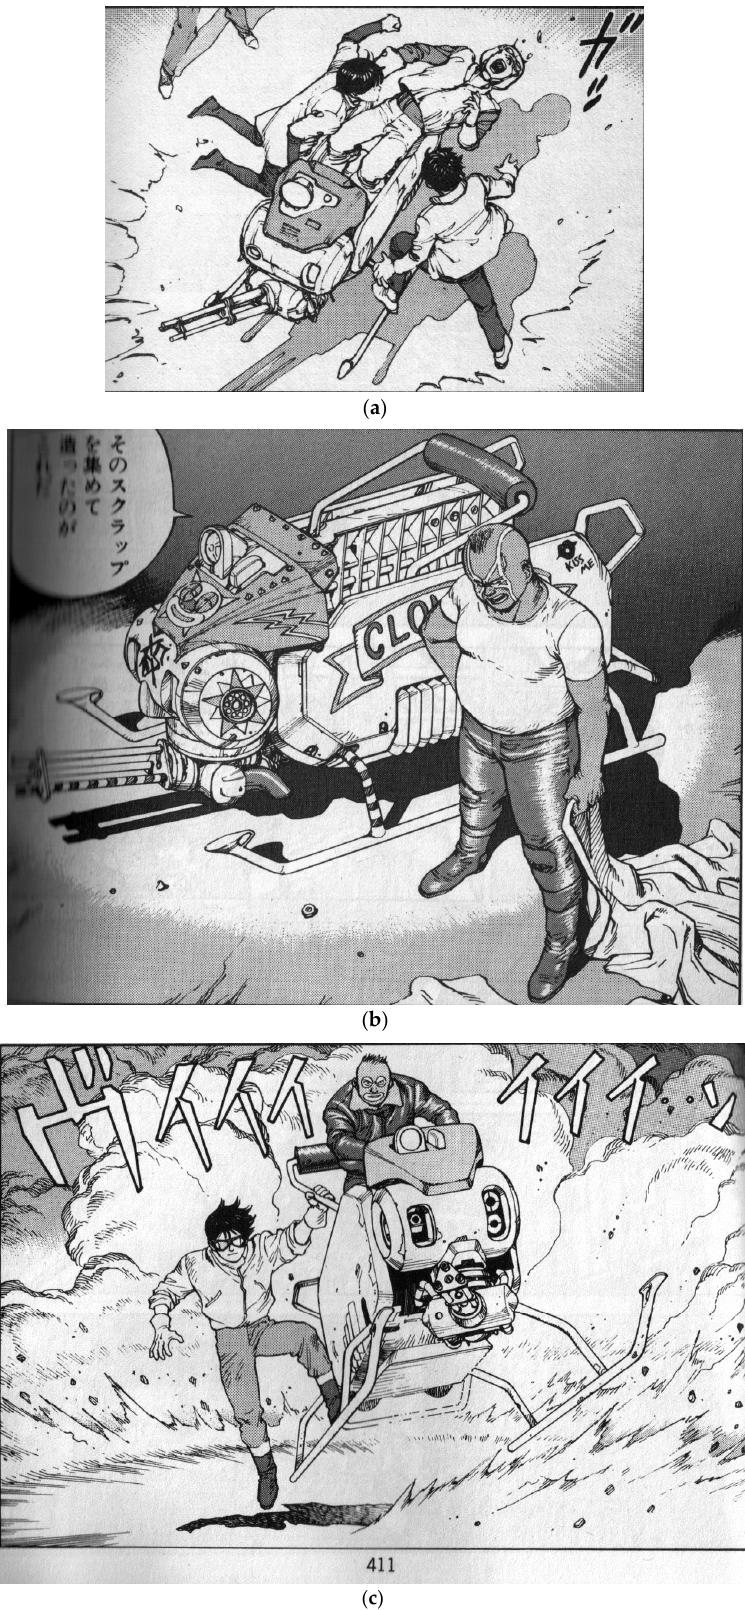
Figure 4. ( a ) panel from Katsuhiro Ō tomo, Akira (K ō dansha), vol. 2 (1985), p. 190; ( b ) vol. 5 (1990), p. 314; ( c ) vol. 6 (1993), p. 411.